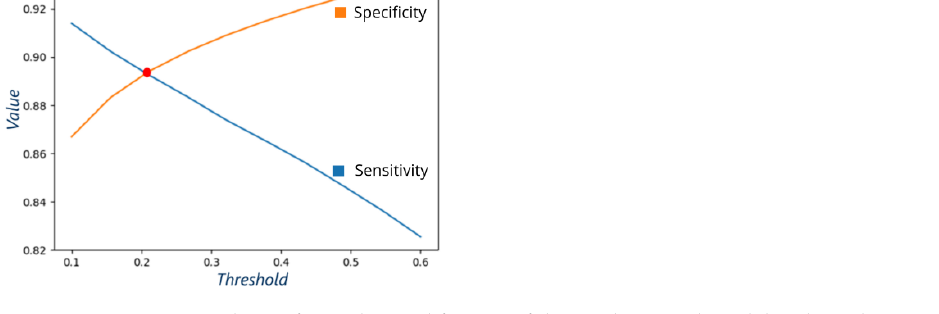
Figure 6. ( a ) Original image; ( b ) Original image with added salt-and-pepper noise; ( c ) Image B after the application of the median filter with window size 5. Prediction maps for three randomly chosen patients are presented in Figure 7. The predictions are very fuzzy, with pixels of both classes interspersed, especially in the bor- der areas; inclusions look remarkably similar to salt-and-pepper noise. That is why it was decided to use the median filter.